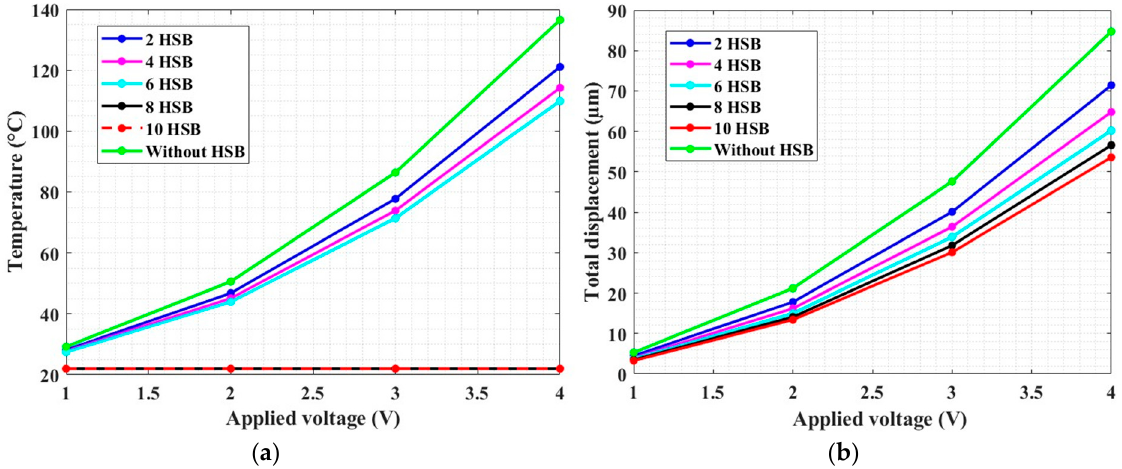
Figure 12. ( a ) Temperature at the tweezer region; ( b ) displacement at the tip of the tweezer for various numbers of heat sink beams (HSB) when the actuator is biased with 1–4 V.